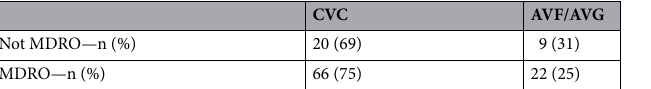
Table 5. Frequency and percentage of MDRO by vascular access type (merged AVF and AVG). MDRO multidrug-resistant organisms, CVC central venous catheter, AVF arteriovenous fistula, AVG arteriovenous